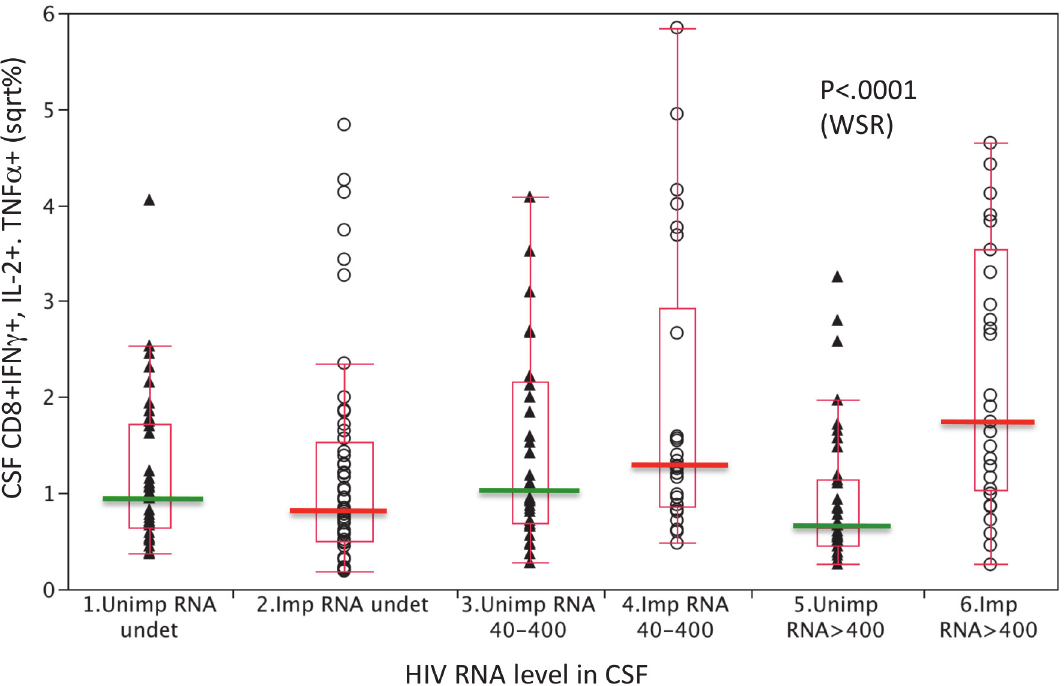
Fig 2. CD8+ T-cells from NC impaired subjects expressed increased levels of constitutive and p24 induced IFN γ , IL-2, and TNF α at higher CSF HIV RNA levels ( > 400 copies/ml). Constitutive and HIV p24 antigen induced CSF CD8+ IFN γ , IL-2, and TNF α expression by normal (triangles) and neurocognitive impaired (circles) subjects were compared at 3 CSF HIV RNA levels. Expression levels were square root transformed. Differences between impaired and unimpaired subjects were significant at higher HIV RNA levels ( > 400 copies/ml) in CSF (WRS = Wilcoxon Rank Sum p < 0.001)